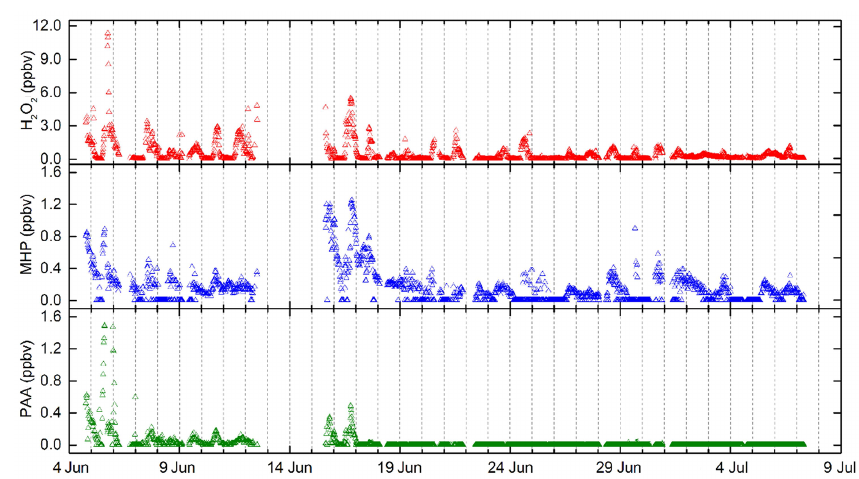
Figure 1. Temporal profile for atmospheric peroxides over the entire Wangdu Campaign 2014.